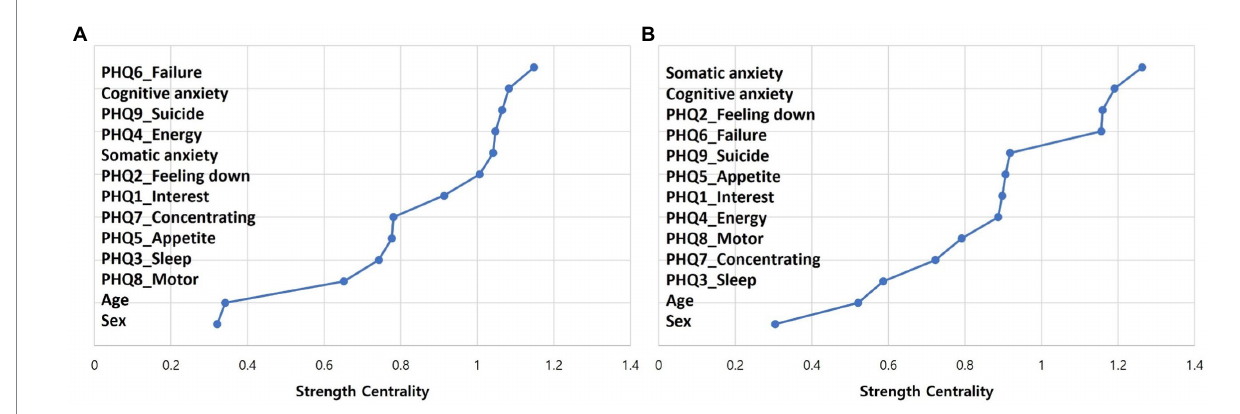
FIGURE 2 Standardized estimate of strength centrality before (A) and during (B) the pandemic. BAI_Som, somatic subscale of the Beck Anxiety Inventory; BAI_ Cog, cognitive subscale of the Beck Anxiety Inventory; Feeling down, item 1 of the Patient Health Questionnaire-9 (PHQ-9); Interest, item 2 of the PHQ-9; Sleep, item 3 of the PHQ-9; Appetite, item 4 of the PHQ-9; Psychomotor, item 5 of the PHQ-9; Energy, item 6 of the PHQ-9; Guilt, item 7 of the PHQ-9; Concentrating, item 8 of the PHQ-9, Suicide, item 9 of the PHQ-9. The X axis shows strength centrality index of nodes, shown as standardized values z scores, and the Y axis shows nodes in order of strength